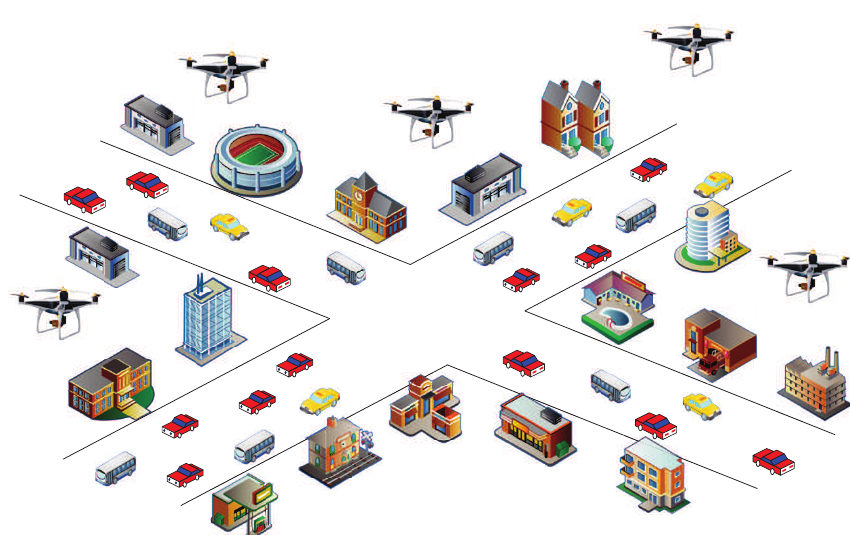
Figure 3. Air–ground integrated vehicular networks.